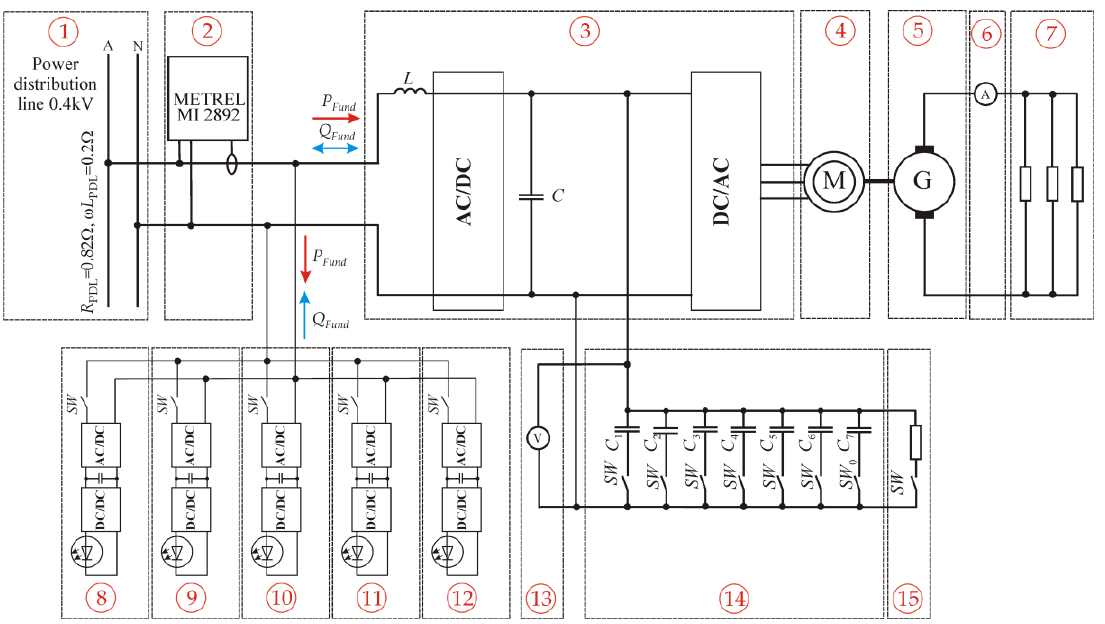
Figure 17. Circuit diagram of experimental setup for the reactive power provided or drawn out by diode rectifier supply-side variable frequency drive and LED light devices analysis.